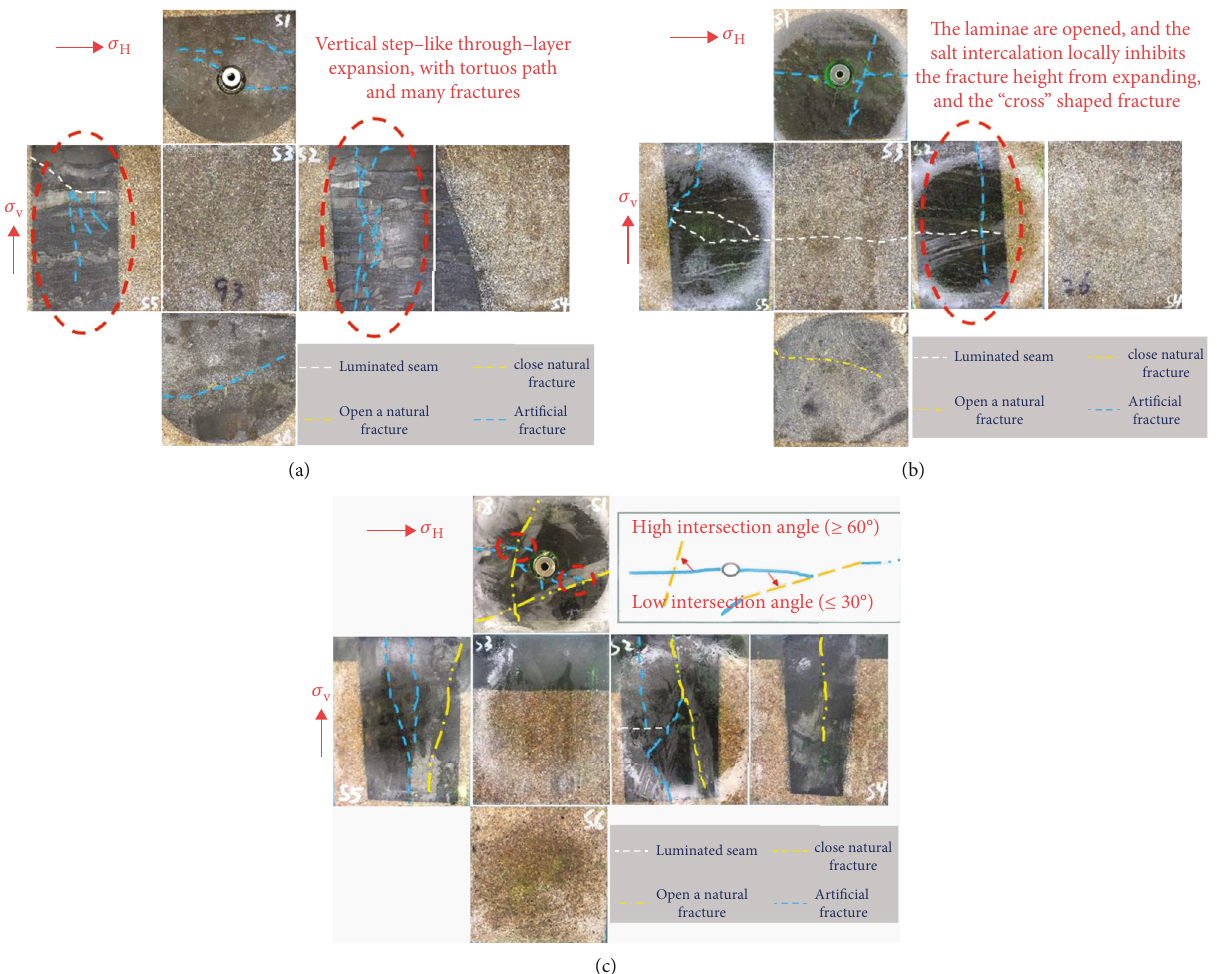
Figure 5: Fracture morphology of sample surface after fracturing. (a) Sample 1#. (b) Sample 2#. (c) Sample 3#.